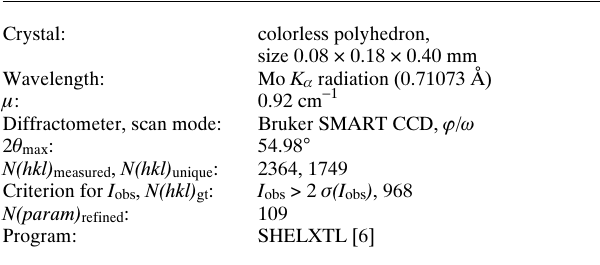
Table 1. Data collection and handling.